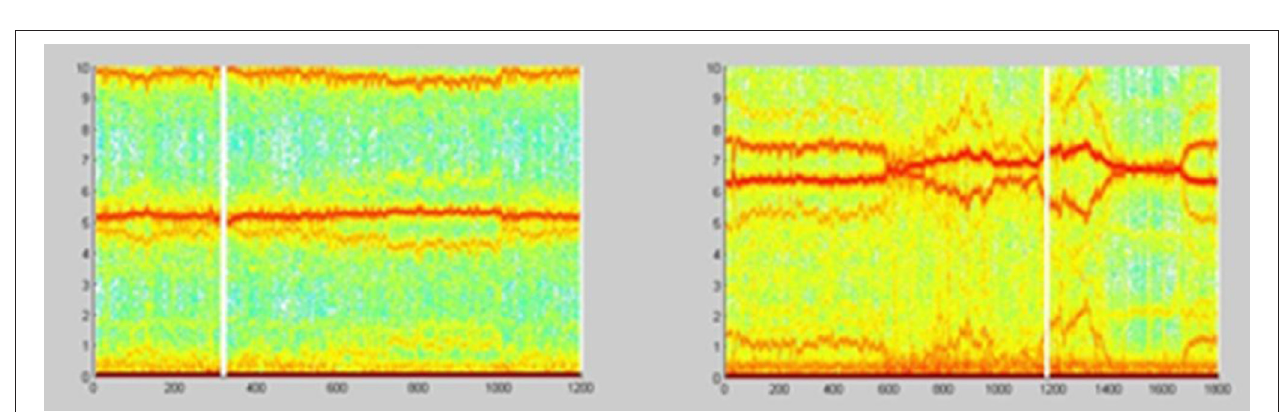
FIGURE 22 | Shown are FFT spectrograms of arterial pressure –AP in hemorrhage experiments, exhibiting the actions of AP modulators present in the AP regulation (system antagonists: renin angiotensin, of sympathetic nervous system and vasopressin). (A) hemorrhage 10%; (B) hemorrhage 10% pretreated with captopril; (C) the same, pretreatment withy phentolamin; (D) pretreatment with the substance V2255 ( Jovanovi ´ c, 2001; Jovanovi ´ c et al., 2014).